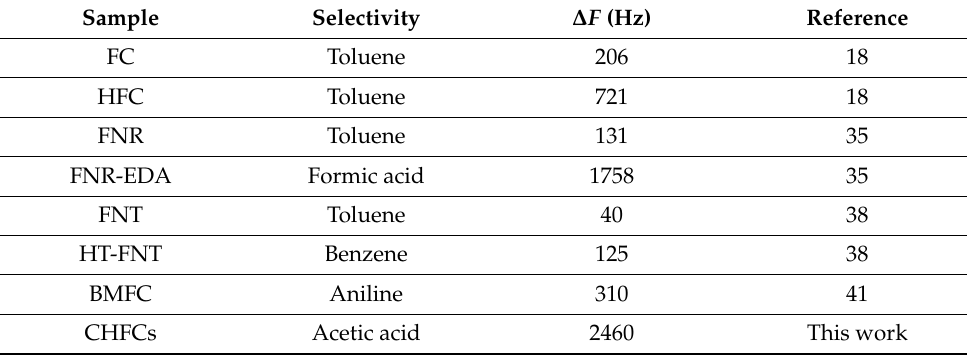
Table 1. The VOCs sensing performance of fullerene